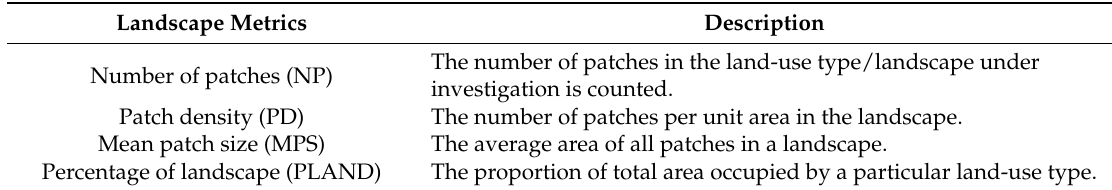
Table 10. Description of four landscape